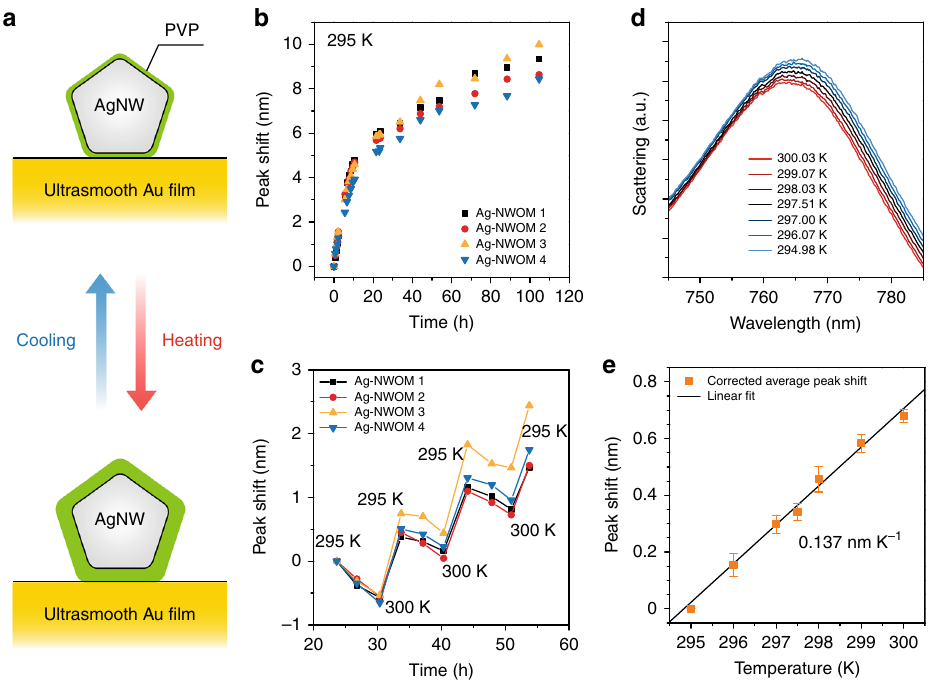
Fig. 3 Sub-picometer vertical differential sensitivity monitoring of the thermal expansion of a PVP layer. a Schematic cross section of the Ag-NWOM system for the measurements of the thermal expansion effect of a PVP layer. b Spectral shift effect at 295 K as a function of measurement time from four individual PVP-coated Ag-NWOMs. c Reproducibility test of the temperature-dependent spectral shift from these four Ag-NWOMs. d Typical dark- fi eld scattering spectra of the single Ag-NWOM as the temperature is increased from 295 to 300 K. e Temperature-dependent average shift of the cavity- plasmon resonance wavelength purely induced by the thermal expansion effect of the PVP layer. The error bars show the range of spectral fl uctuation by averaging the results from the four